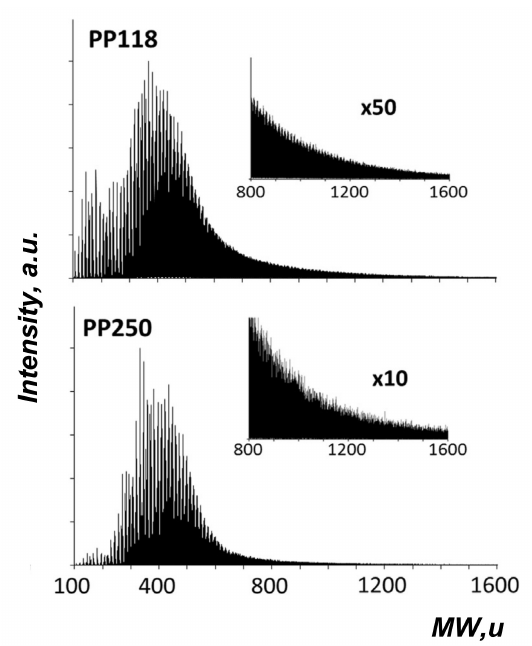
Figure 7. Spectra of two different petroleum pitches with different softening points (PP118, T softening = 118 ◦ C and PP250, T softening = 250 ◦ C), acquired by LDI-TOF MS adapted from [52] with